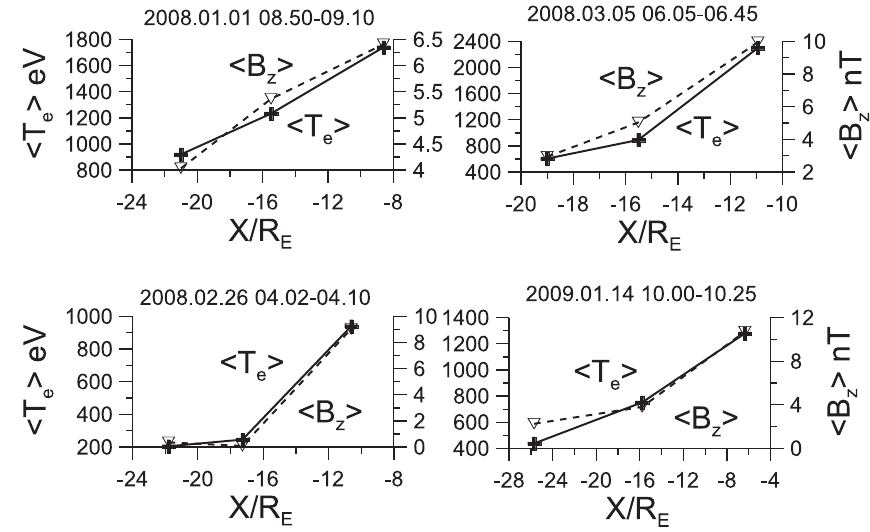
Fig. 2. Profiles of the average electron temperature h T e i (shown by solid lines) and the magnetic field h B z i (shown by dotted lines) along the tail.